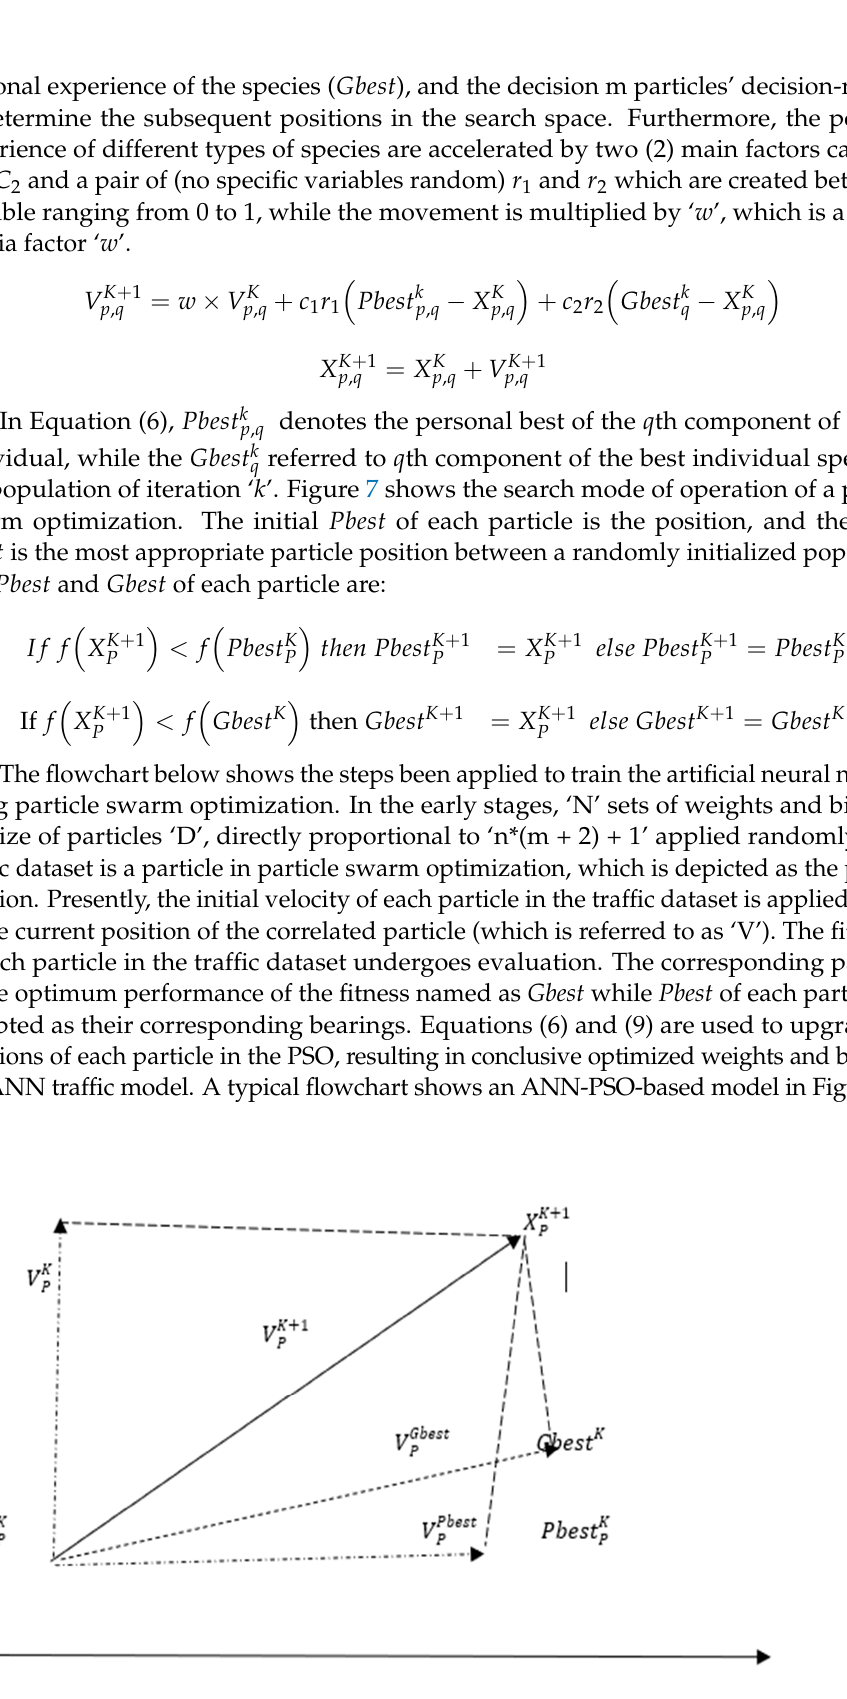
Figure 7. The Particle Swarm Optimization search technique for p th particle at a k th objective function in the search field.